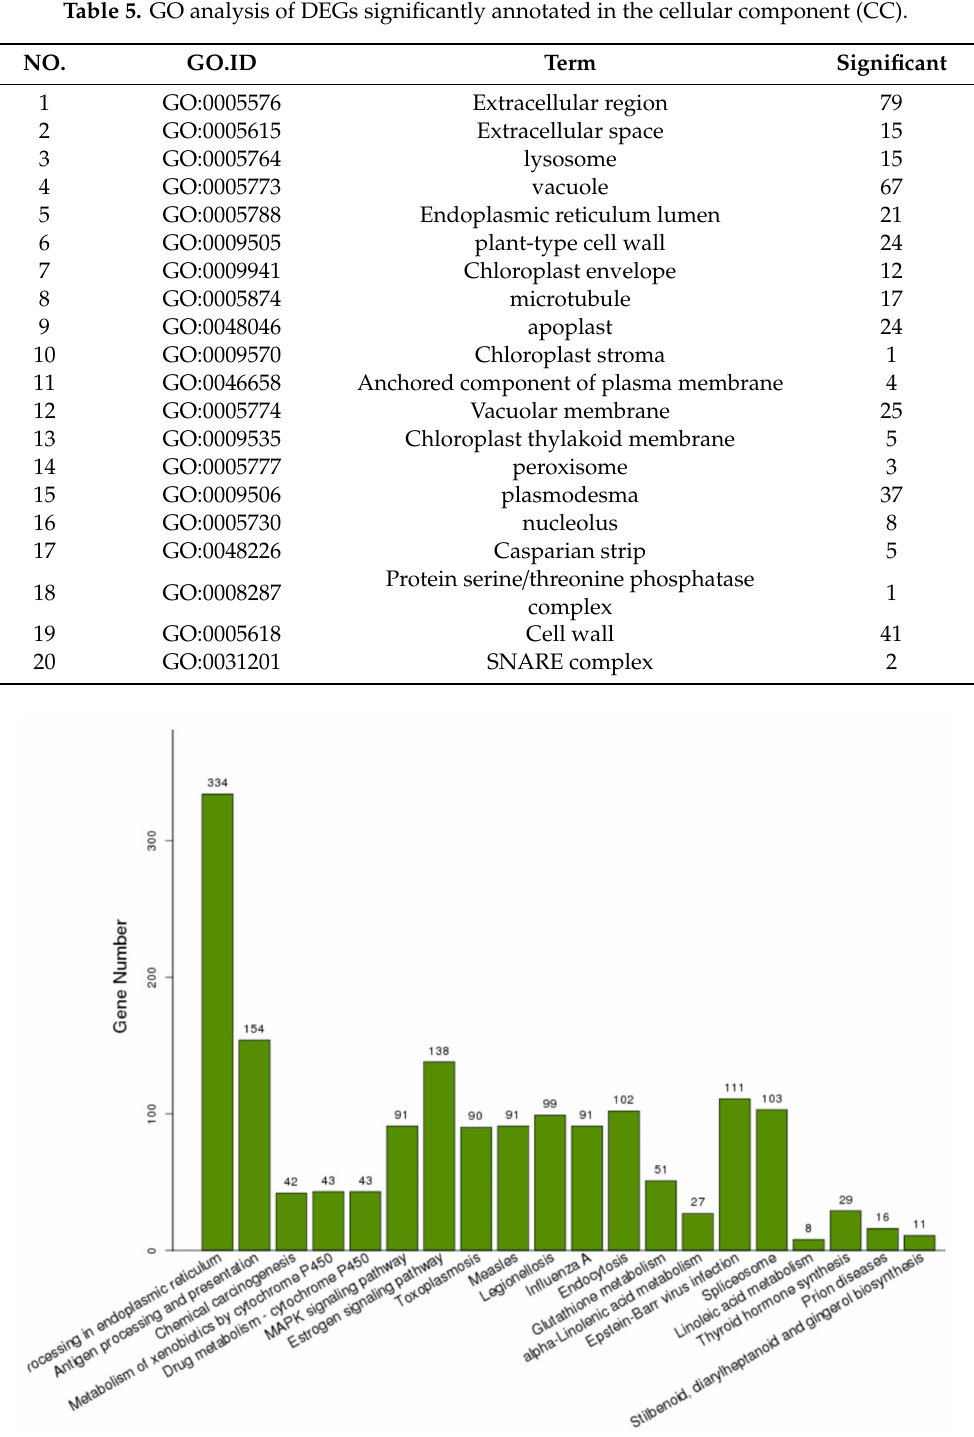
Figure 4. KEGG pathway enrichment analysis based on the DEGs significantly enriched in